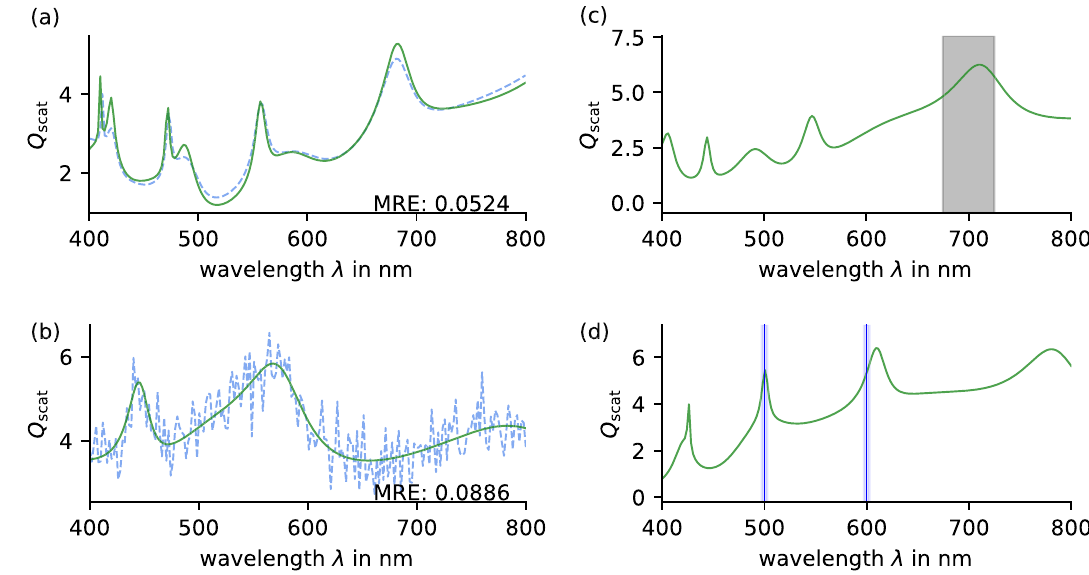
Figure 4. ( a ) Optimization on target spectrum (solid line) of a seven-layered core-shell particle with a deviation of 5.2%. ( b ) Optimization on noised target. ( c ) Modified objective to enhance scattering efficiency for wavelengths within 675 nm and 724 nm. ( d ) Targeting peaks at 500 nm and 600